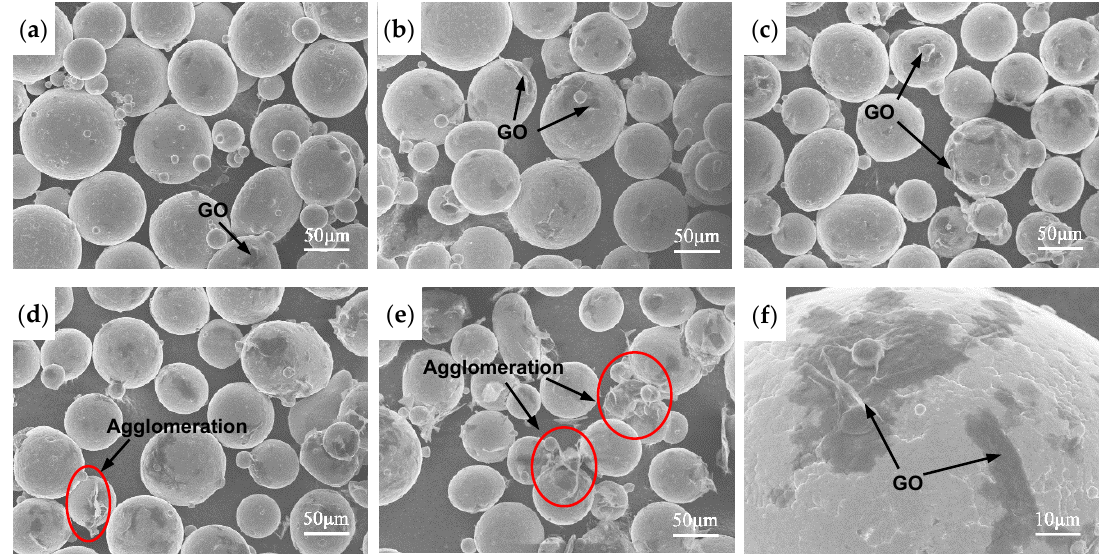
Figure 4. SEM images of the mixed powders with different addition amounts of GO ( a ) 0.05 wt%; ( b ) 0.15 wt%; ( c ) 0.3 wt%; ( d ) 0.4 wt%; ( e ) 0.5 wt%; ( f ) GO adsorbed on the surface of titanium alloy particle.